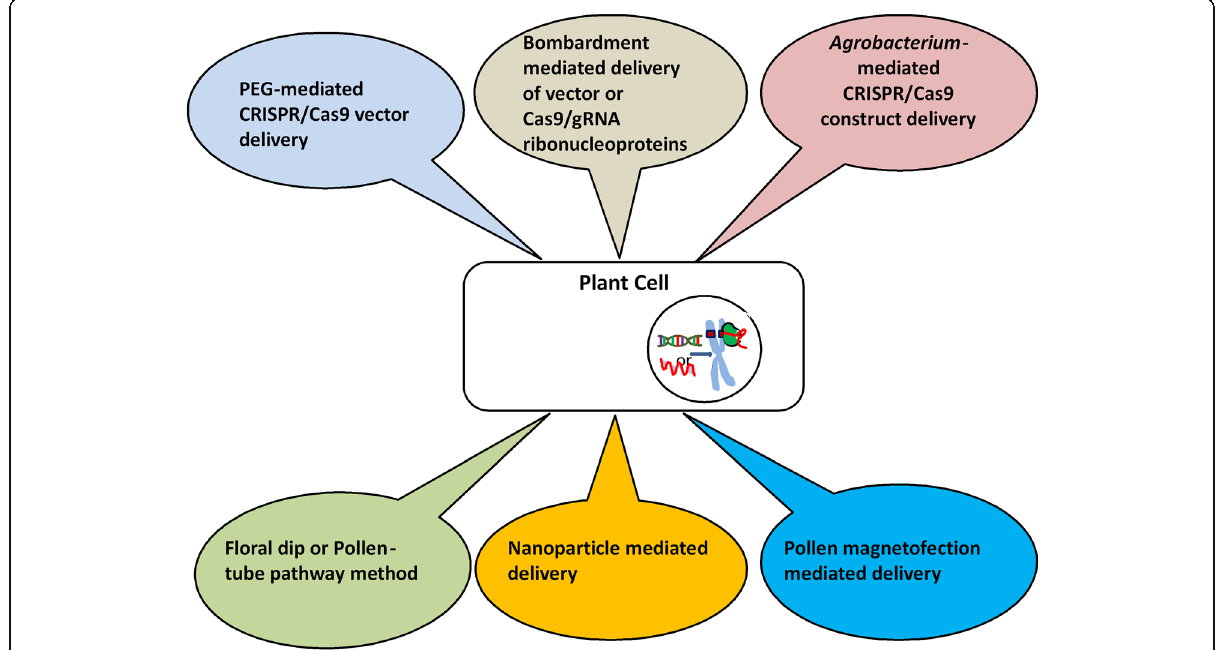
Fig. 1 Existing and potential future CRISPR/Cas9 delivery methods. Different well-known delivery methods such as Agrobacterium -mediated delivery, Bombardment-mediated delivery, PEG-mediated delivery, and floral dip or pollen-tube tube pathway method. Potential pollen magnetofection-mediated delivery and nanoparticle-mediated delivery will be useful in near future to avoid tissue